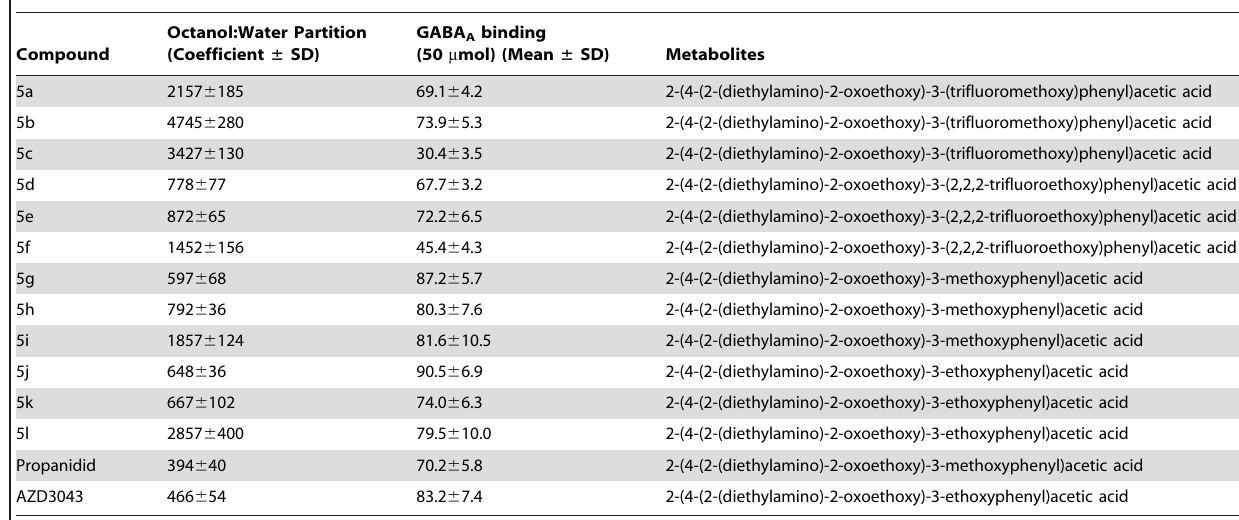
Table 4. Chemical data of fluorine substituted phenyl acetate